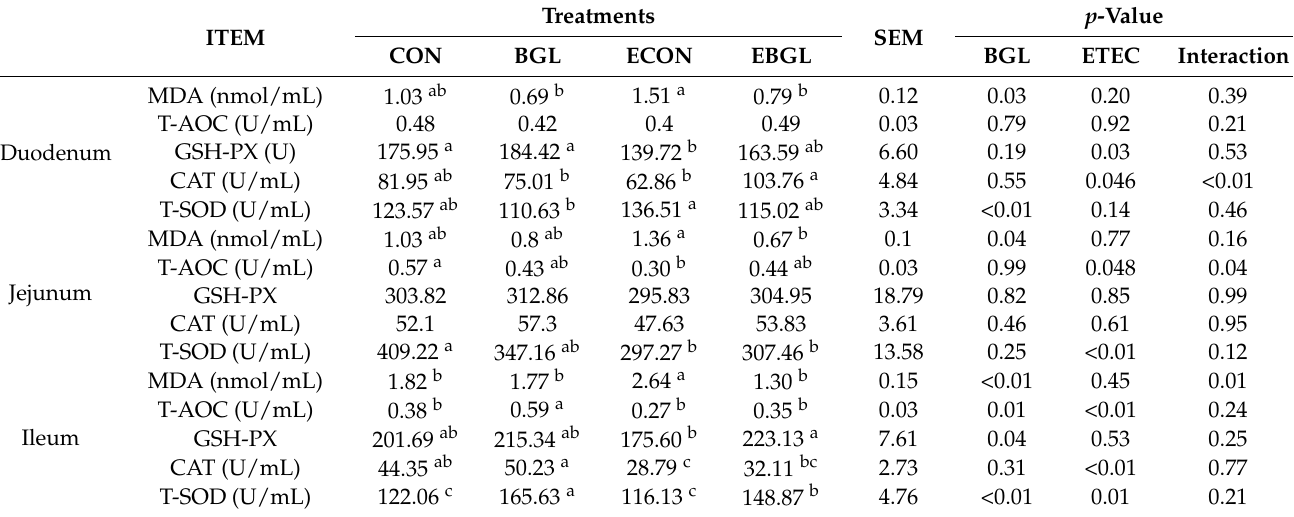
Table 2. Effect of BGL on intestinal antioxidant in weaned pigs upon ETEC